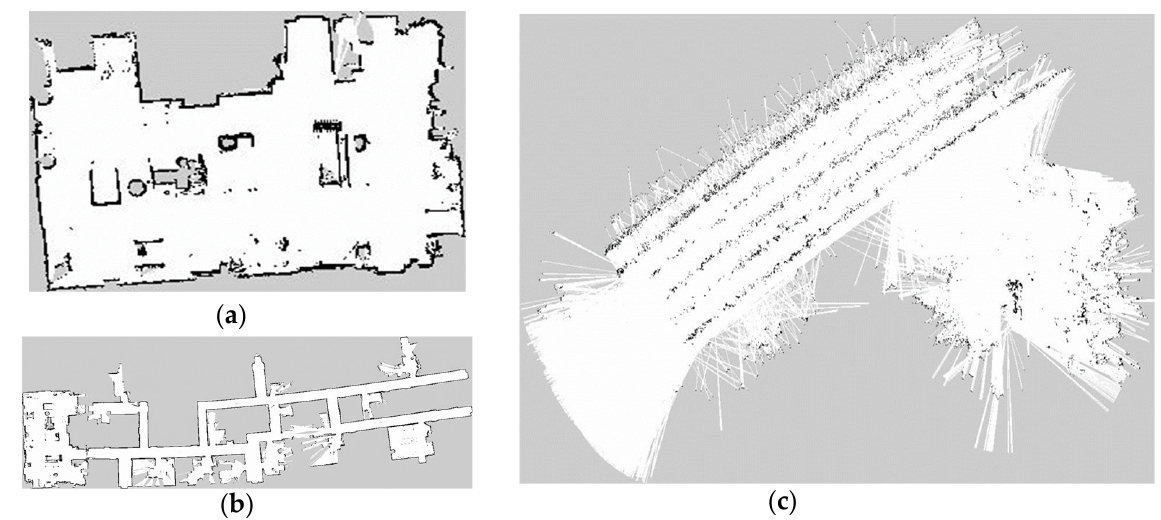
Figure 15. Map of ( a ) Sensor and Automation Laboratory, ( b ) Edisto-REC hallways, and ( c ) cotton field showing five crop rows.